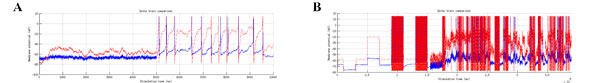
Experimental results obtained with the generated equation (62.34/v4) + (v/(20.165- v))2 +0.34. In blue the reference signal, and in red dotted the signal generated with the previous equation. (a) Simulation within 1 s. (b) Simulation within 39 s.